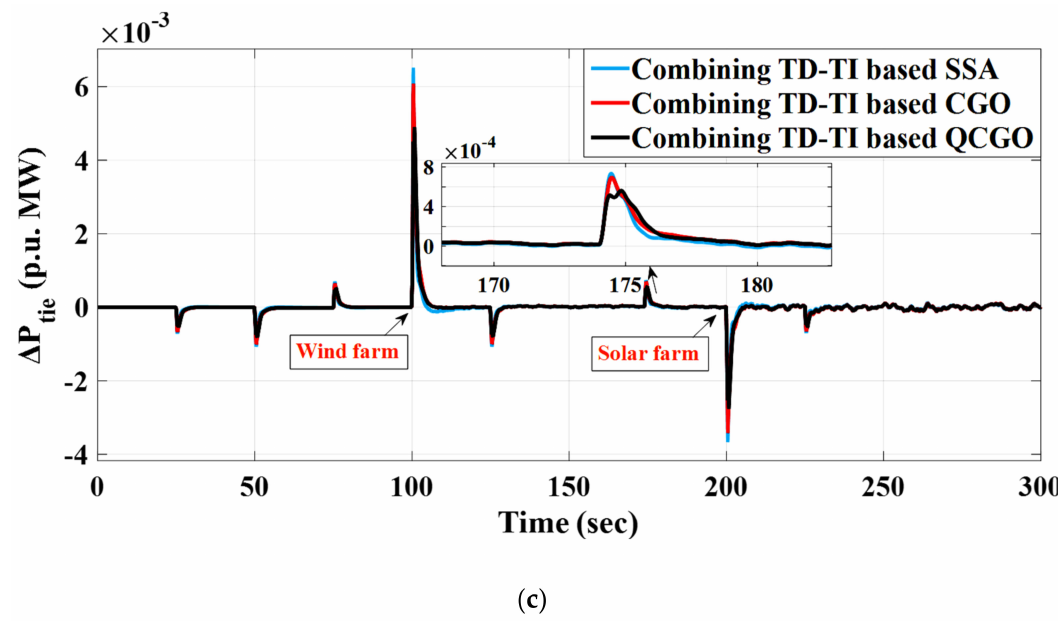
Figure 24. Dynamic power grid responses in case B.2: ( a ) ∆ f